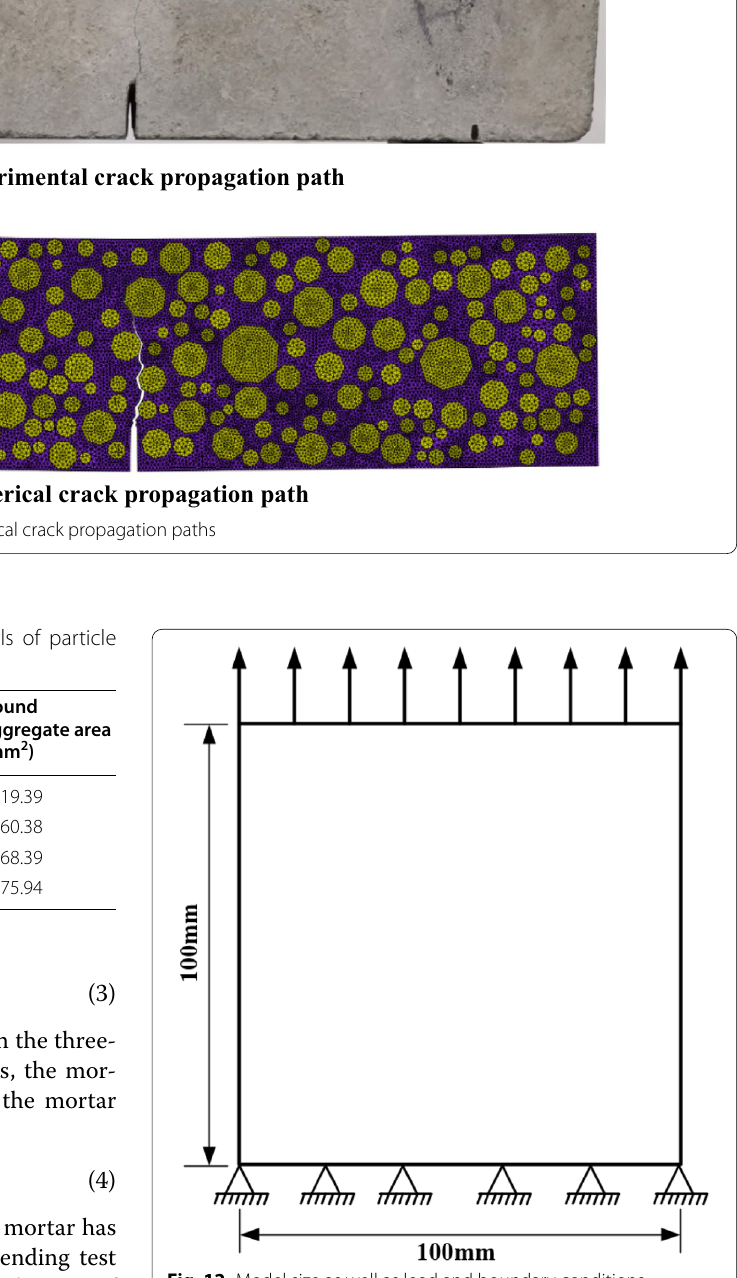
Fig. 12 Model size as well as load and boundary